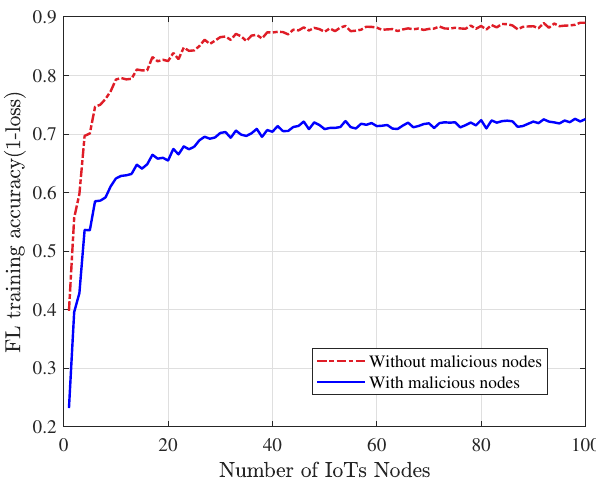
Figure 7. FL training